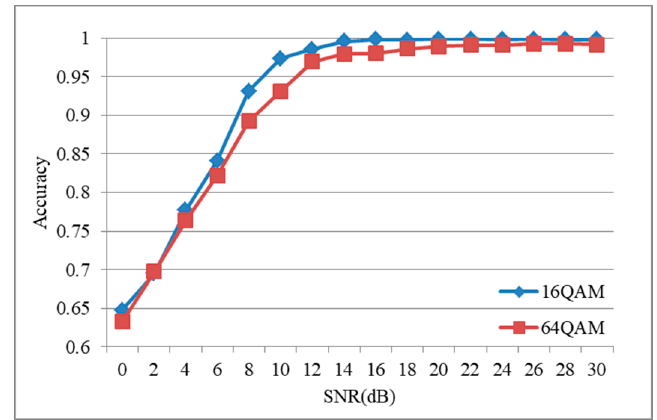
Figure 9. Classification accuracy of each SNR of the real dataset RealSig. The MobileNet_V2 model is fine-tuned.